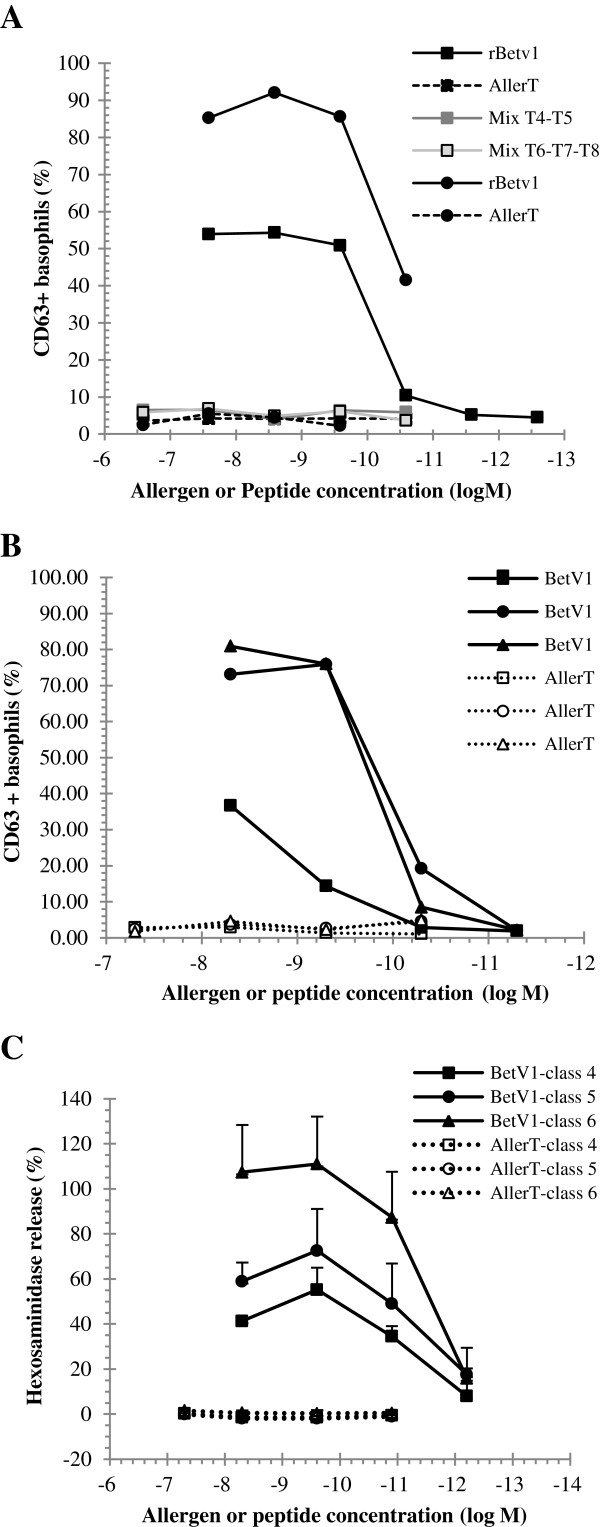
Human basophil degranulation assay. Panel A: Basophils from two subjects allergic to birch (circle and square symbols) were activated by rBet v 1, AllerT, T4-T5 or T6-T7-T8 mixes at indicated concentrations. Panel B: Basophils from a non-allergic donor were pre-incubated with sera from 3 subjects allergic to birch (circles, squares and triangles) and incubated with the indicated concentrations of rBet v 1 and AllerT. Degranulation is expressed as the percentage of CD63 positive basophils. Panel C: Rat basophils expressing hu FcϵRI were pre-incubated with sera from 10 subjects allergic birch and reacted with either rBet v 1 or AllerT (filled and open symbols respectively). Results were grouped by IgE class levels as determined by the ImmunoCAP assay (classes 4 to 6; n= 3 or 4 sera per class). Hexosaminidase release is expressed as the percentage of release induced by anti-total IgE antiserum.